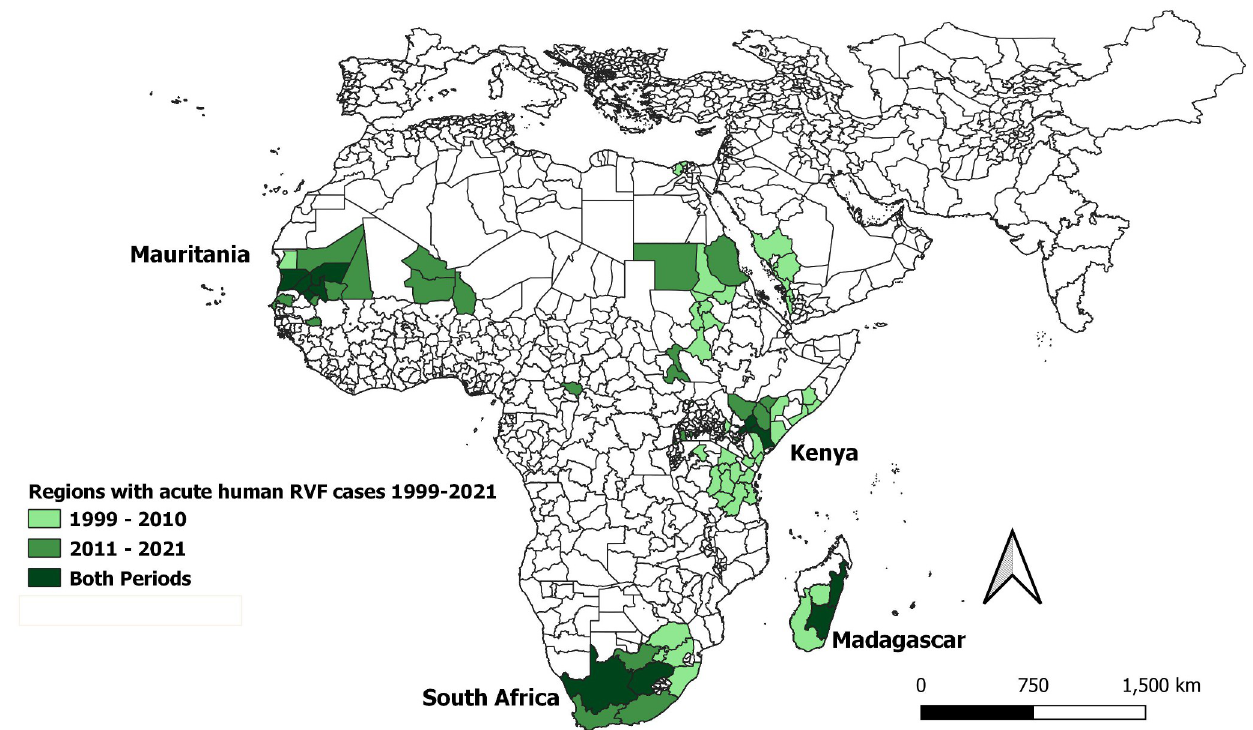
Fig 3. Sub-national administrative regions experiencing acute human cases of RVF during the years 1999–2021. Locations are shaded according to whether they experienced outbreaks before or after 2011, or if they had outbreaks during both periods. Base map is from Database of Global Administrative Areas (GADM) (version 3.4, (April 2018, www.gadm.org/data.html).